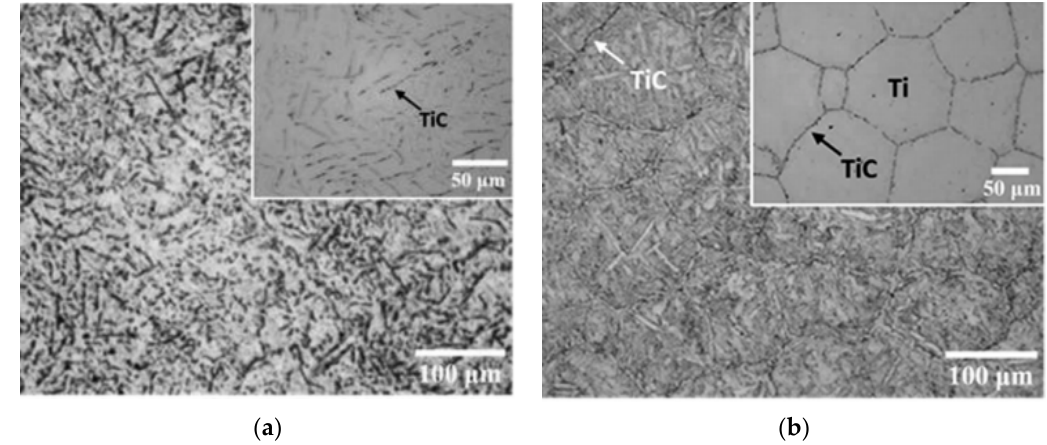
Figure 14. Optical micrographs showing the consolidation of Ti-3TiC MA powders: ( a ) by EDS with 2.85 kJ/g, attaining crystallite sizes of about 40 and 54 nm for Ti and TiC, respectively; ( b ) by SPS, with TiC uniformly distributed only along the Ti particle boundary. Reprinted with permission from ref. [73] Copyright 2019 Elsevier.